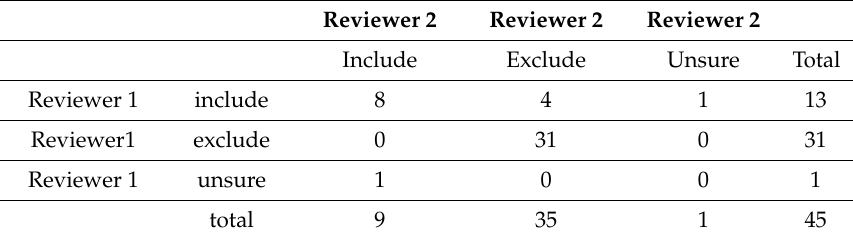
Table 2. K agreement calculation, Po = 0.86 (Proportion of agreement), Pe = 0.594 (Agreement expected), K agreement = 0.655 ( < 0 no agreement, 0.0–0.20 slight agreement, 0.21–0.40 fair agreement,